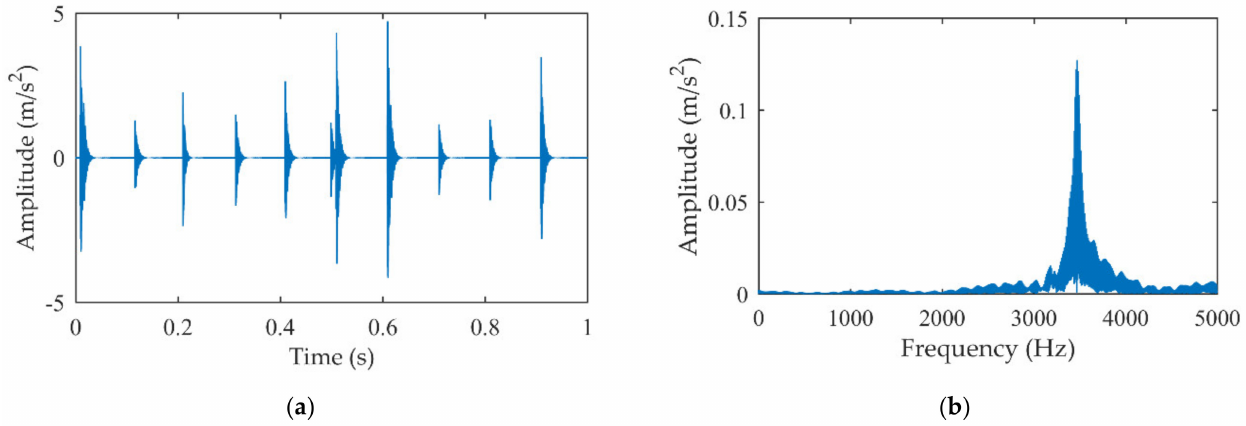
Figure 4. Theextractedimpactsignalbyproposedmethod: ( a )Timedomainsignal; ( b